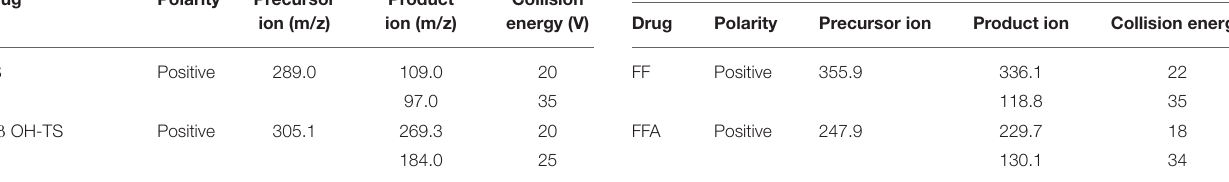
TABLE 4 | Optimized characteristic ion mass spectrometry parameters for FF and